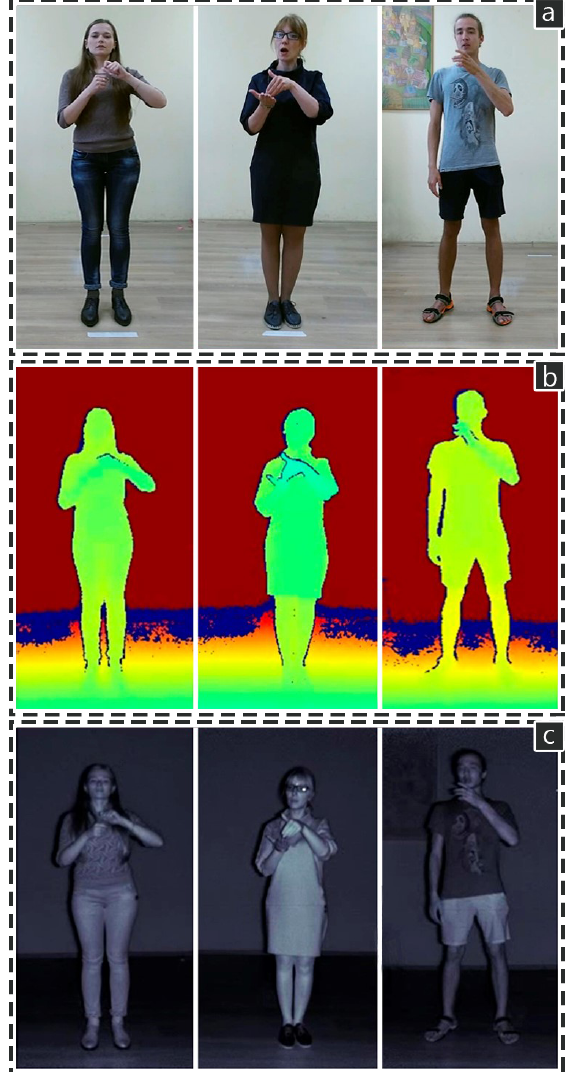
Figure 3. Examples of frames showing gestures in FullHD format (top row), in the depth map mode (middle row) and in the infrared range (bottom